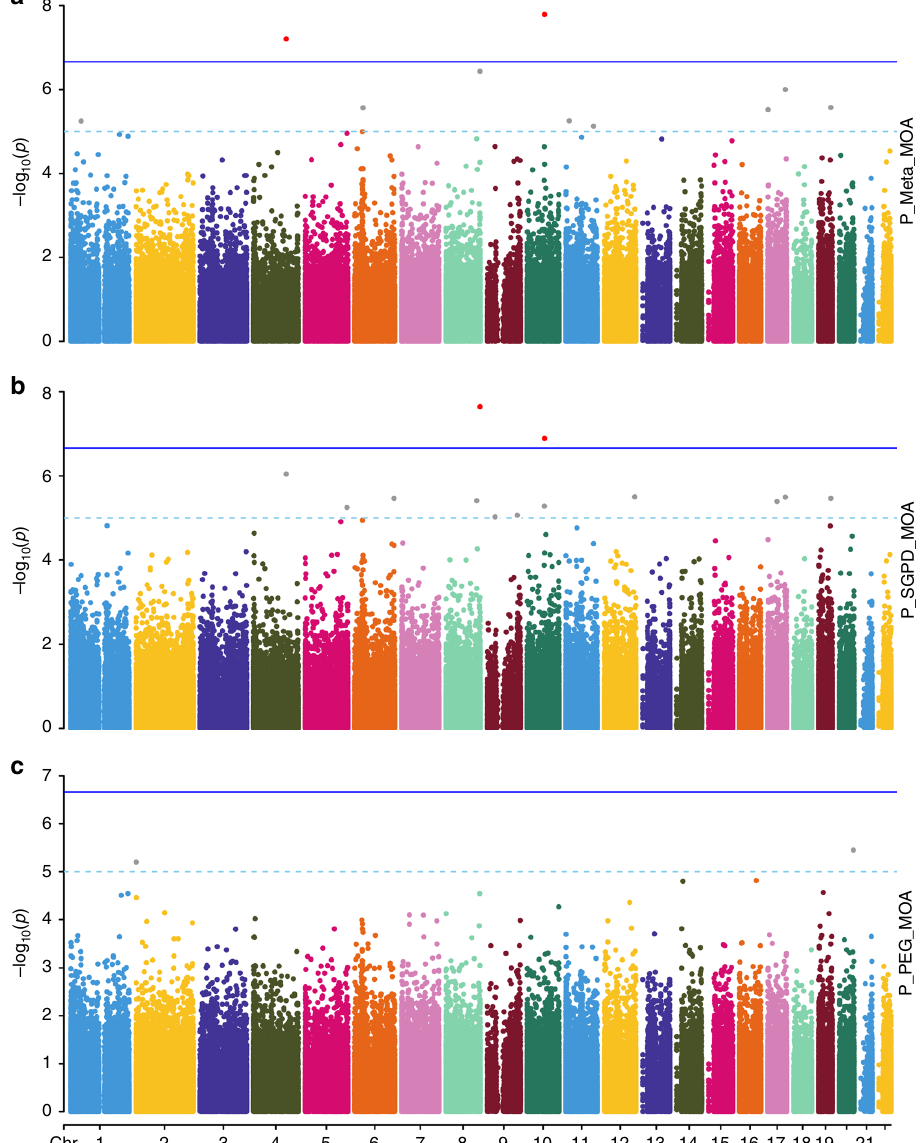
Fig. 2 Manhattan plots of MOA MWAS of PD. a MOA MWAS meta-analysis of PD in the SGPD and PEG cohorts ( N = 2131 individuals); b MOA MWAS of PD in the SGPD data set ( N = 1638 individuals); c MOA MWAS for PD in the PEG data set ( N = 493 individuals).